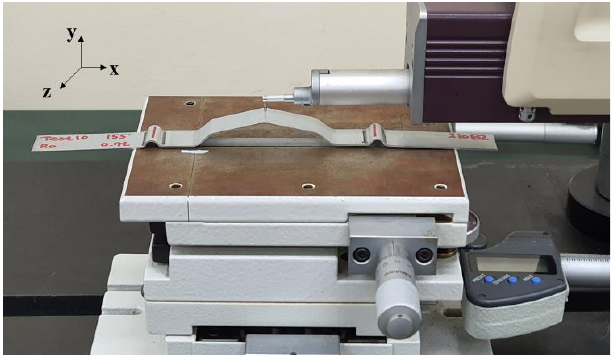
Figure 9. Surface profile measuring using a roughness tester (Mitutoyo SJ-400).